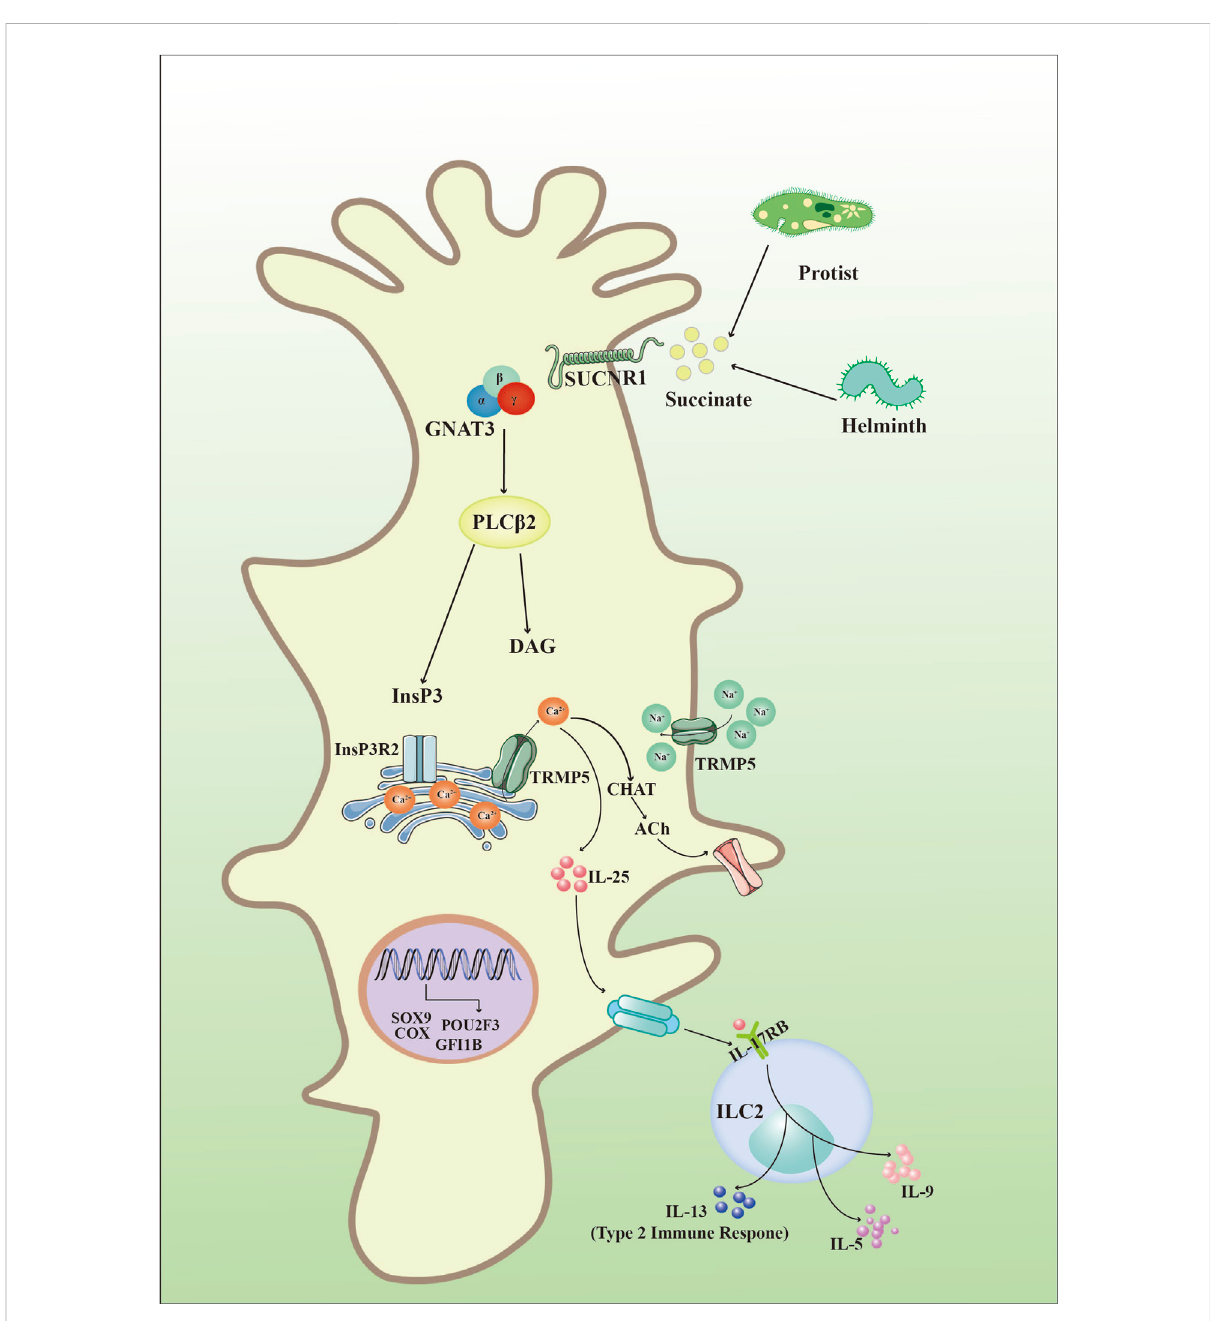
Intestinal tuft cell-speci fi c signaling. Invasive organisms including helminths and protozoa produce succinate to bind with succinate receptor 1 (SUCNR1), which further interacts with guanine nucleotide-binding protein G(t) subunit α 3 (GNAT3) and activates phospholipase C β 2 (PLC β 2) to produce inositol-1,4,5- trisphosphate (InsP3) and diacylglycerol (DAG). InsP3 then binds to its receptors (InsP3Rs) in the endoplasmic reticulum and causes the release of Ca 2+ into the cytoplasm. Subsequently, increased Ca 2+ in the cytoplasm activates transient receptor potential cation channelsubfamilyMmember5(TRPM5)andresultsin:(1)cholineacetyltransferase(CHAT)-mediatedreleaseofacetylcholine(ACh);(2)secretionof IL-25 to bind with interleukin 17 receptor B (IL-17RB) in group 2 innate lymphoid cells (ILC2s) and synthesize cytokines such as IL-5, IL-9, and